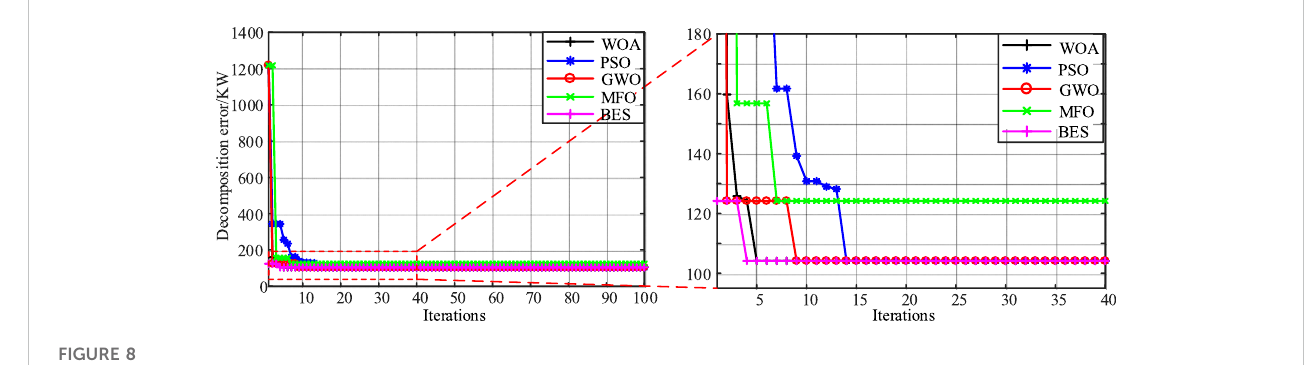
FIGURE 8 Optimization process of multi optimization